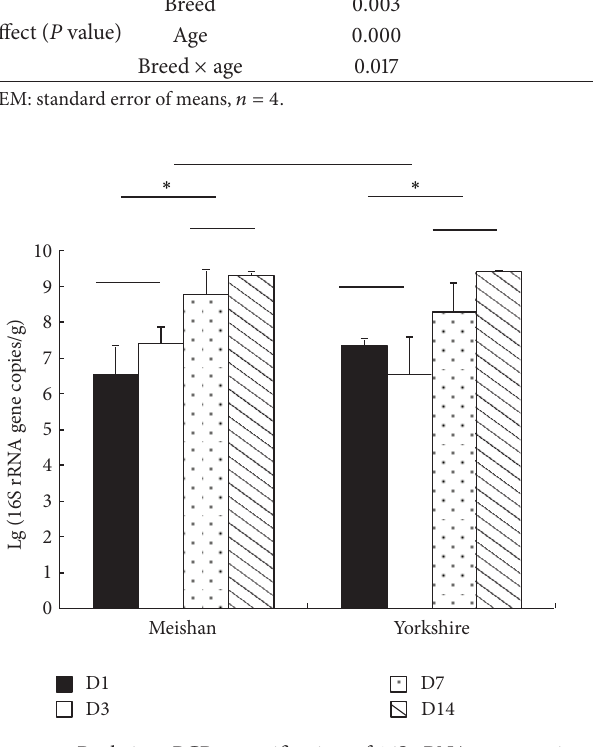
Figure 5: Real-time PCR quantification of 16S rRNA gene copies of methanogenic archaea in the faeces of Meishan and Yorkshire piglets. ∗ 𝑃 < 0.05 , 𝑛 = 4